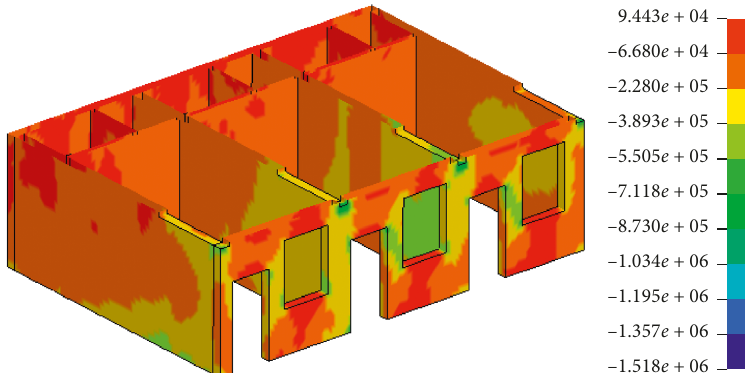
Figure 21: PCS contour of first floor section the structure ( t � 0.058 s) (unit: Pa). Table 7: PCS and PCS ratio of local members under different peak particle